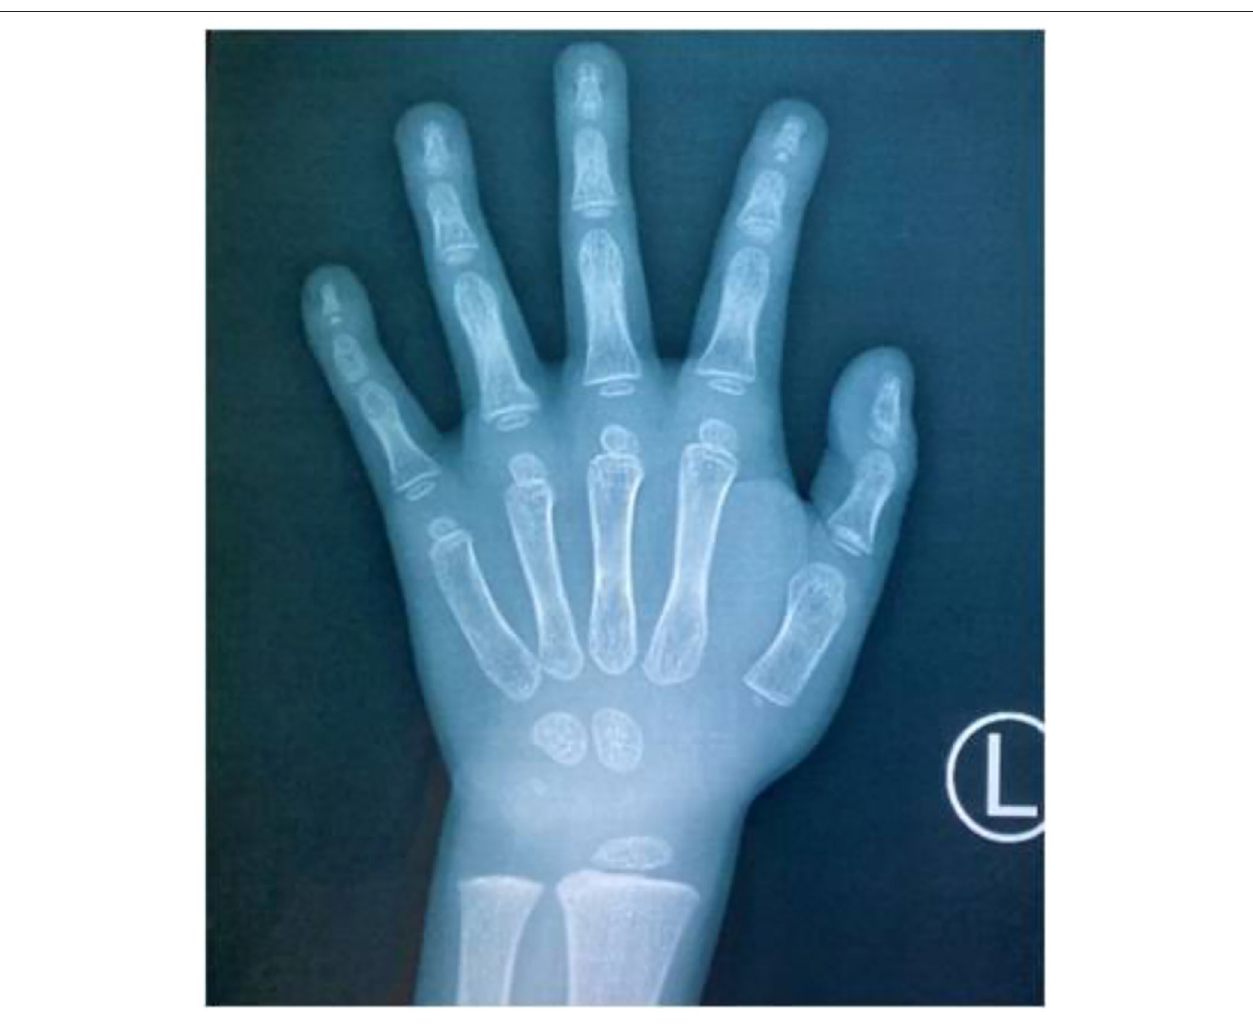
Frontiers in Pediatrics |